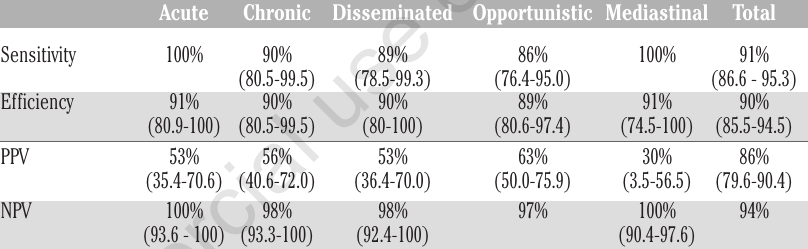
Table 6. Serological parameters and descriptive measurements of the indirect ELISA for detection of antibodies in different clinical forms of histoplasmosis. Acute Chronic Disseminated Opportunistic Mediastinal